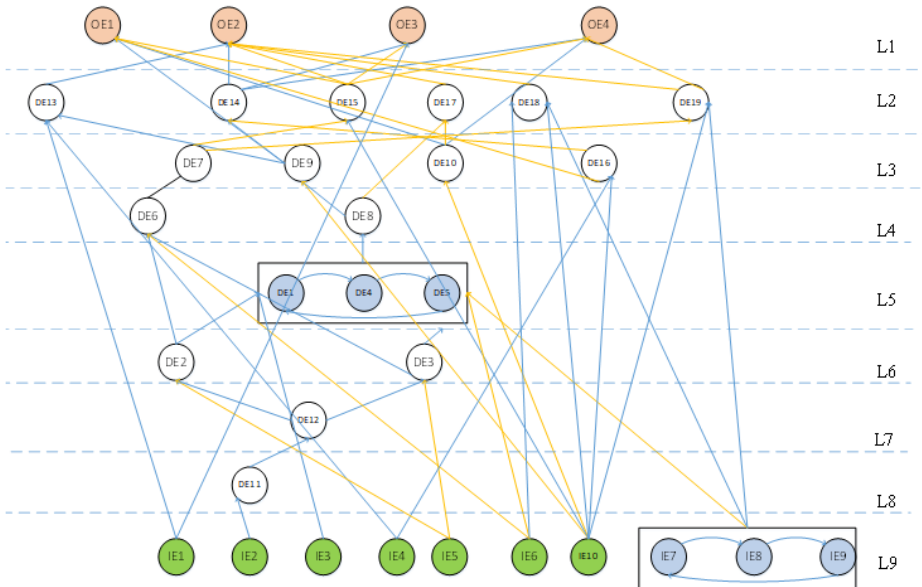
Figure 6. Digraph for the limit value | 𝐶 𝑖𝑗 |=>1.75.